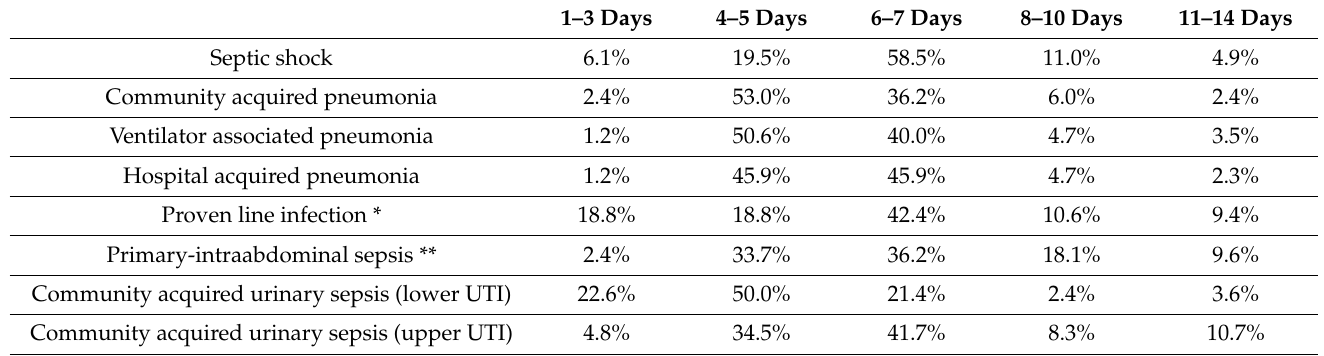
Table 1. The standard duration of empirical antibiotics for common infections in ICU across the